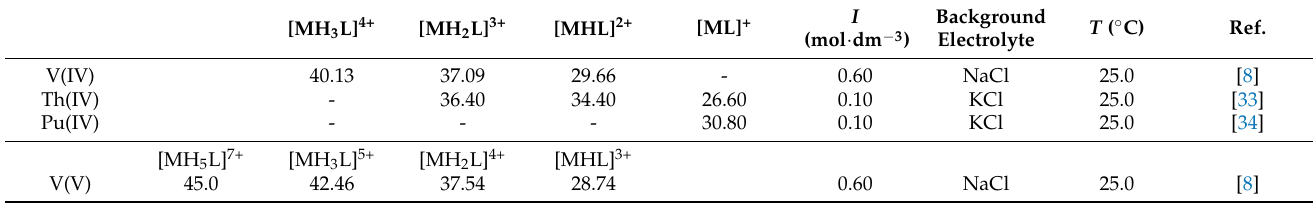
Table 7. Overall complex-formation constants (log β ) of DFOB with high valence metal ions, under different experimental conditions.